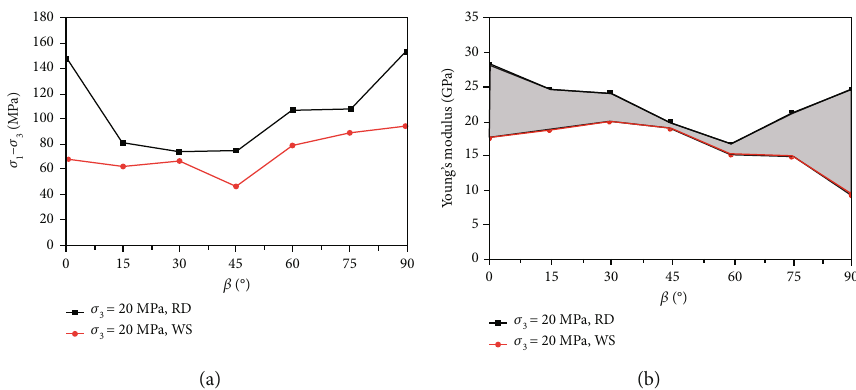
Figure 14: (a) Comparison of the compressive strength of the dry (RD) and water-saturated (WS) samples from Cheng et al. [16]. (b) Comparison of Young ’ s modulus of the dry (RD) and water-saturated (WS) samples from Cheng et al. [16].